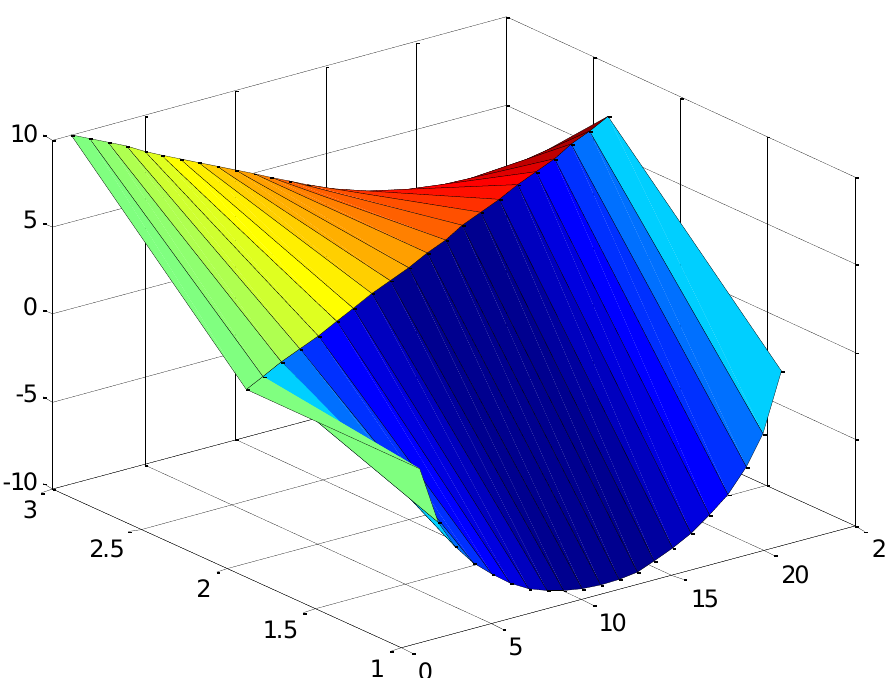
Figure 4. The plot of solution to dissipative wave equation with local fractional operators with fractal